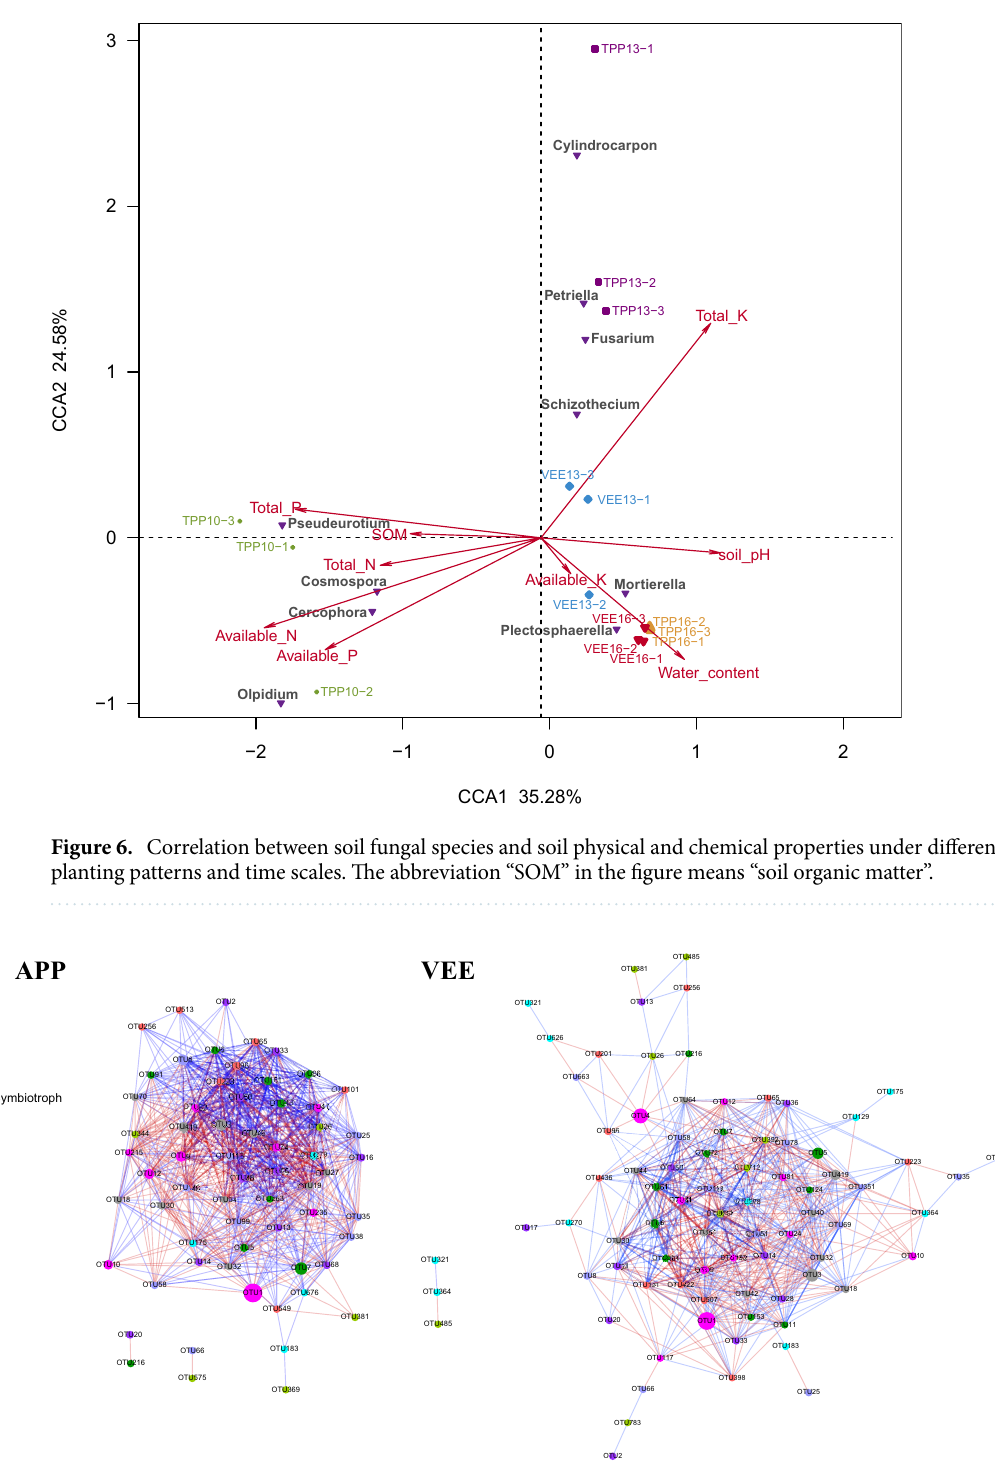
Figure 7. The relationship network of soil fungal trophic types and communities under different planting